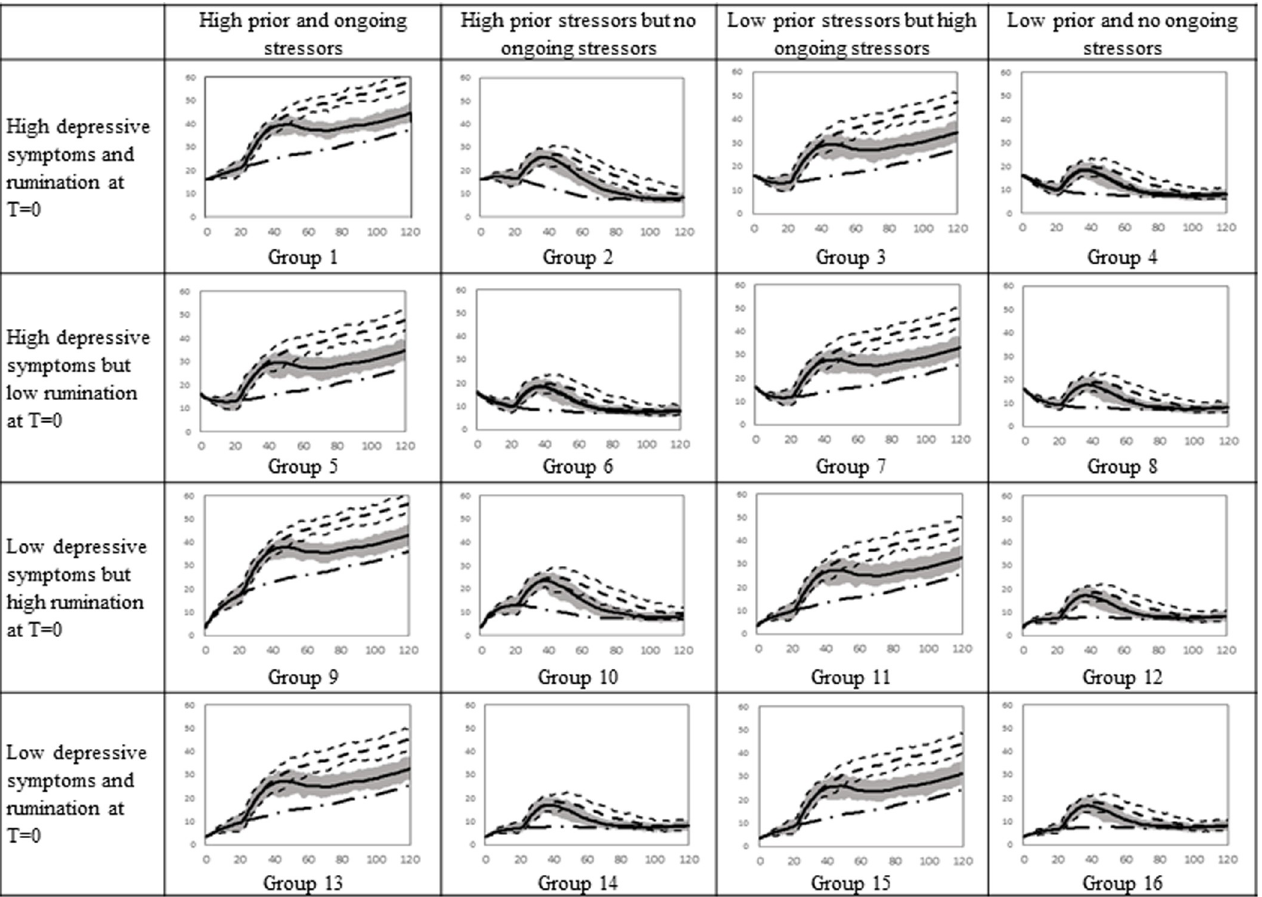
Fig 4. Simulated depressive symptoms for 16 female groups who experienced a stressful life event at month 20 and therapy at month 30. The long-dash- dot line captures the baseline output. The dashed line depicts the depressive symptoms when girls experience a stressful life event at month 20. The solid line shows the results when they experience a stressful life event at month 20 and then therapy at month